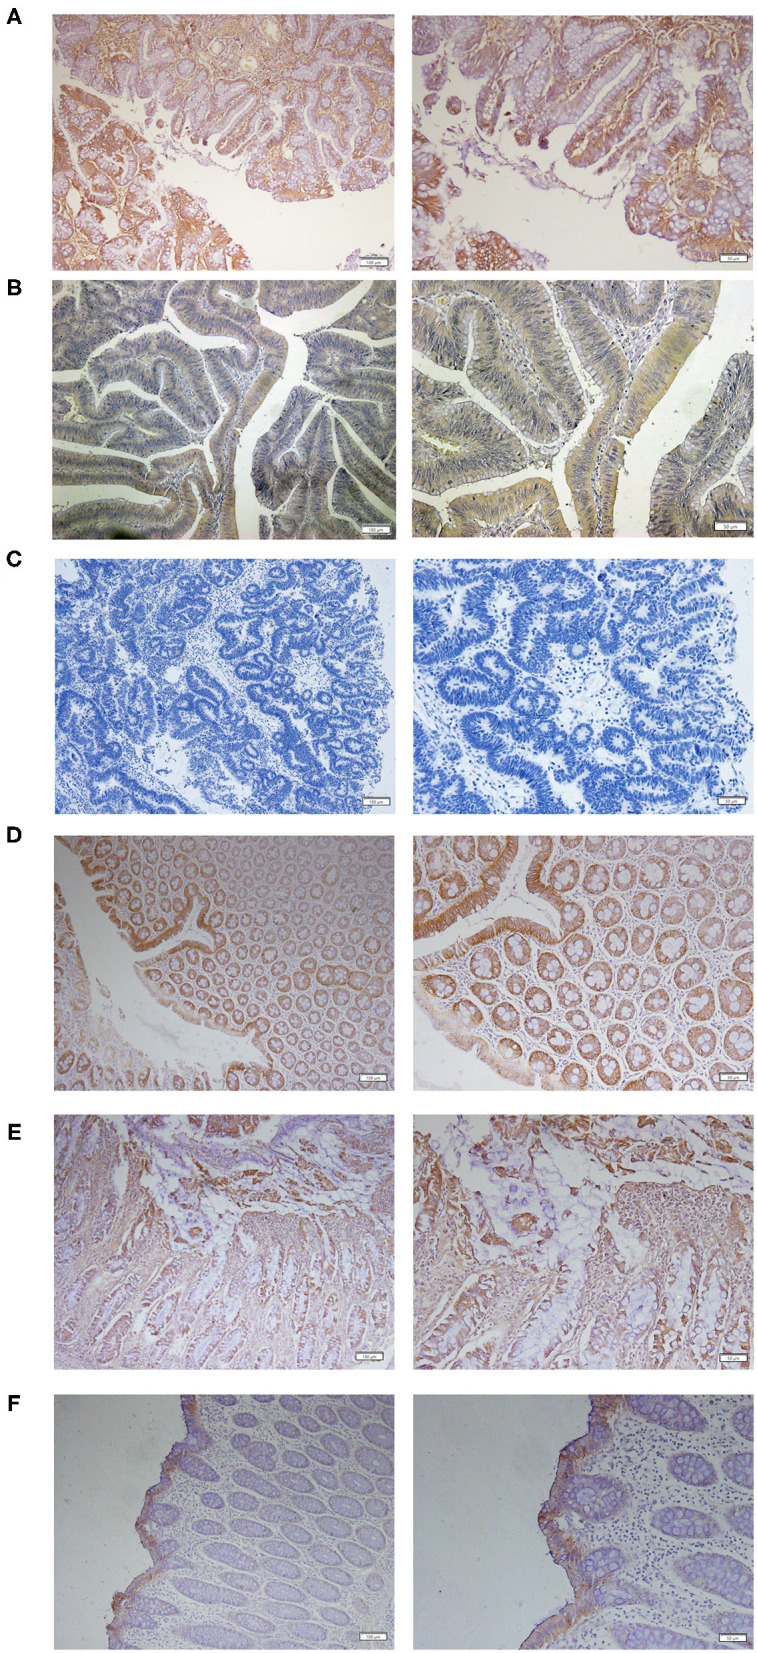
Expression of TMEM16A in human colorectal cancer. (A) Representative IHC images of medium expression of TMEM16A. (B) Representative IHC images of low expression of TMEM16A. (C) Representative images of negative staining for TMEM16A. (D) Representative images of IHC staining showing TMEM16A expression in glands and mucosa of colorectal cancer tissues. (E) Expression of TMEM16A in glands and connective tissue of colorectal cancer. (F) Expression of TMEM16A on the mucosal surface of colorectal carcinoma.